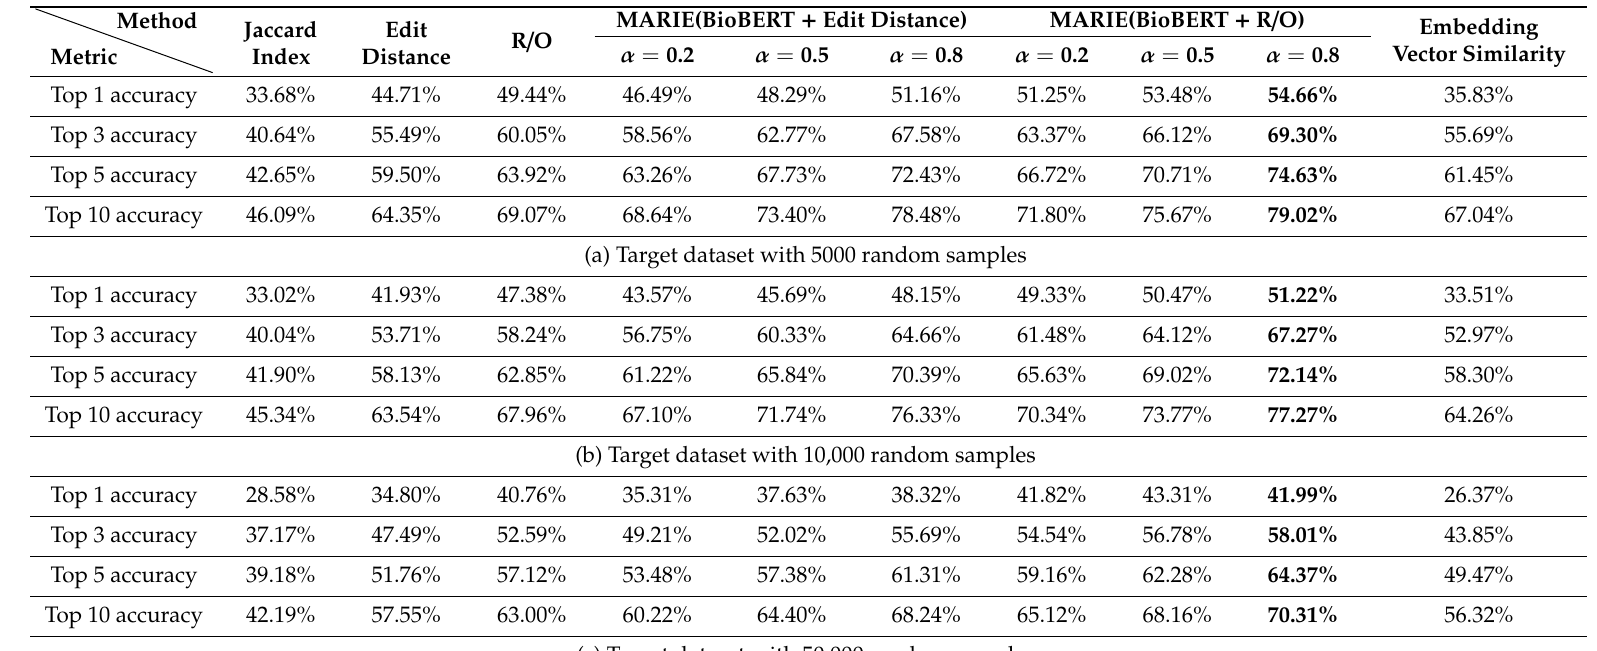
Table 1. Experiment results in biomedical mapping terminologies between Seoul National University Hospital (SNUH corpus) and three artificial target datasets. Compared with other existing mapping methods, MARIE showed superior mapping accuracy, which was further improved by changing the value of α